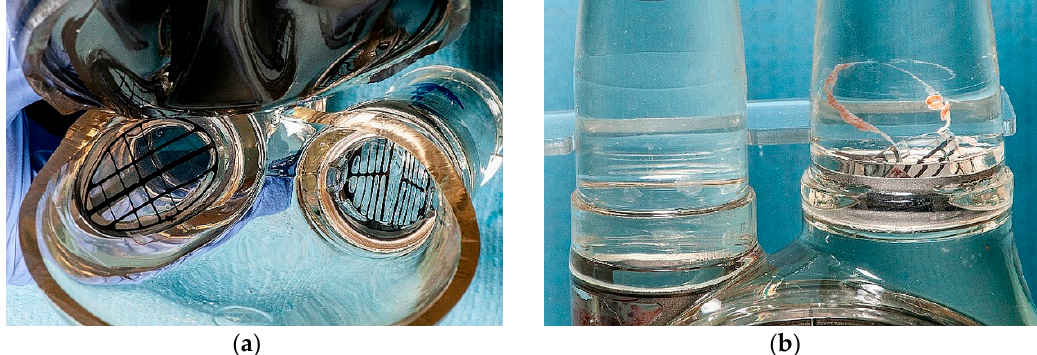
Figure 19. View of valves after in-vitro thrombogenicity study: ( a ) view from the inside of the blood chamber on the inflow and outflow valves, ( b ) side view at the place where the valves are glued in.